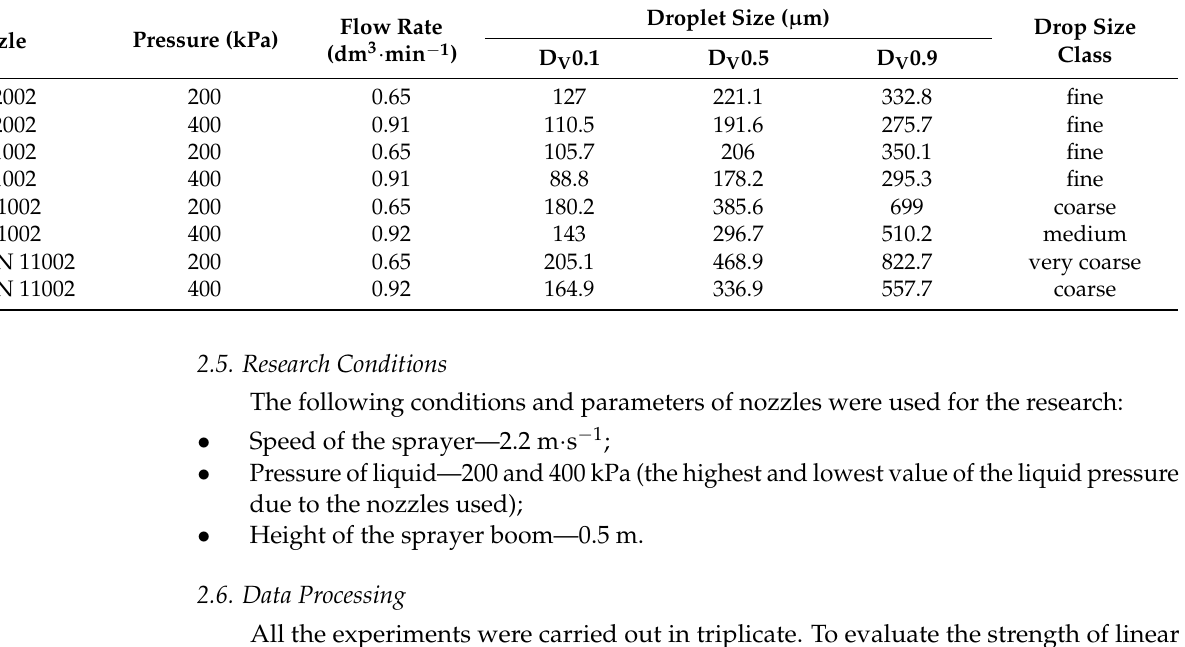
and air induction. Droplet size classifications are based on the ASABE S572.1 [48]. The